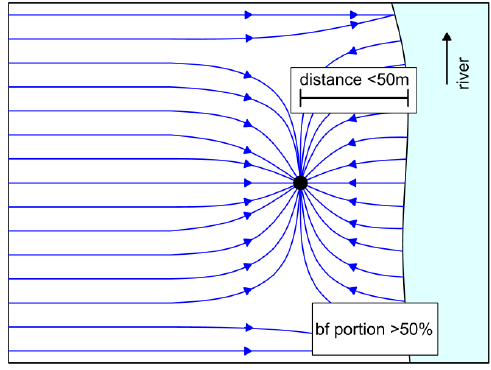
Figure 13. Well placed near the riverbank, pumping more than 50% bank filtrate (bf). Water 2017 , 9 , 317